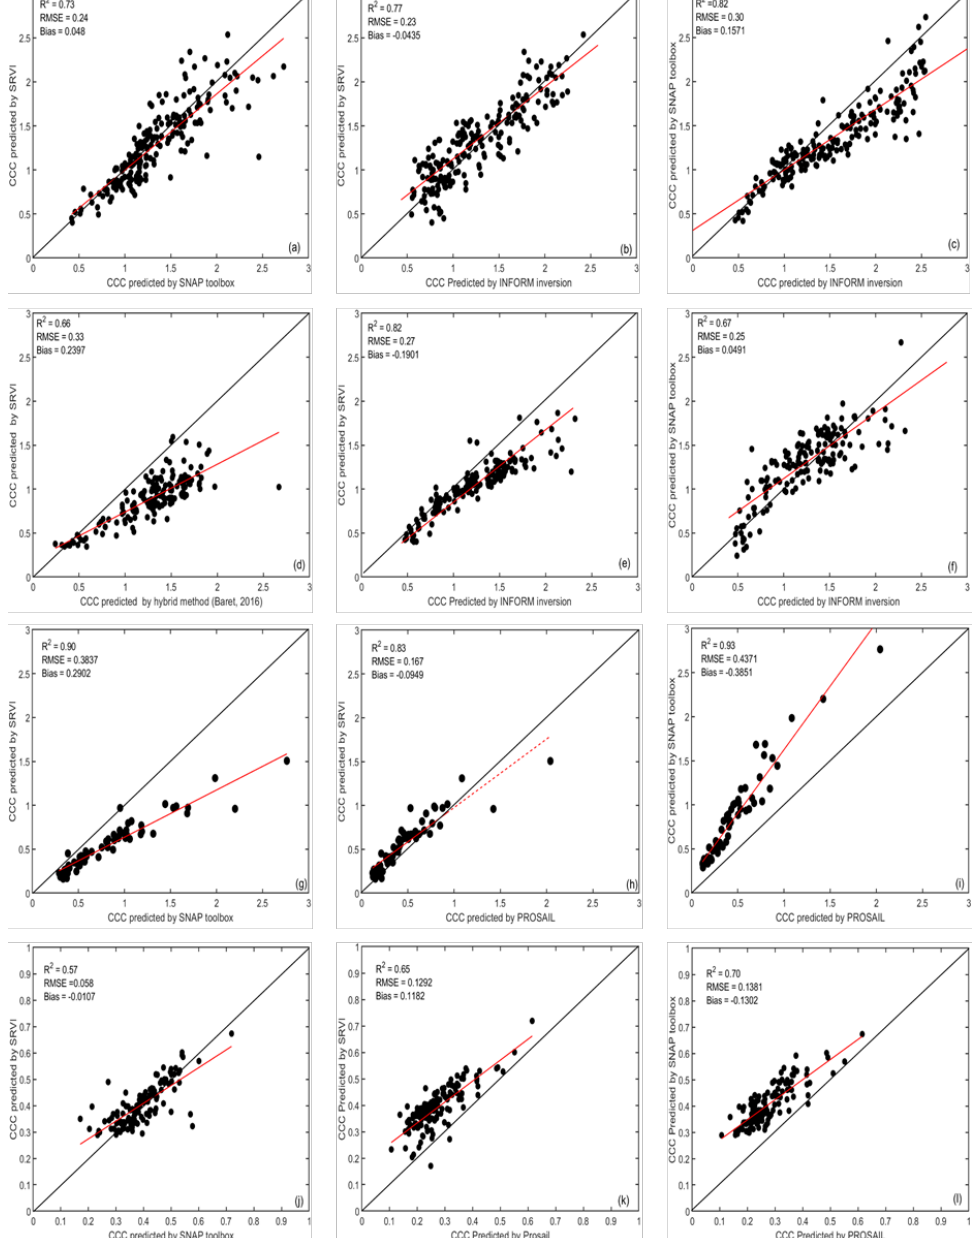
Figure 7. Robustness of the selected approaches against each other in predicting CCC of Bavarian temperate forest ( a – c ), Lambir tropical forest ( d – f ), Camargue Mediterranean wetland ( g – i ), and Kytalyk arctic tundra biome ( j – l ). The lines in black show the 1:1 relationship, whereas the lines in red indicate the relationship between the estimated CCC values by the tested algorithms.